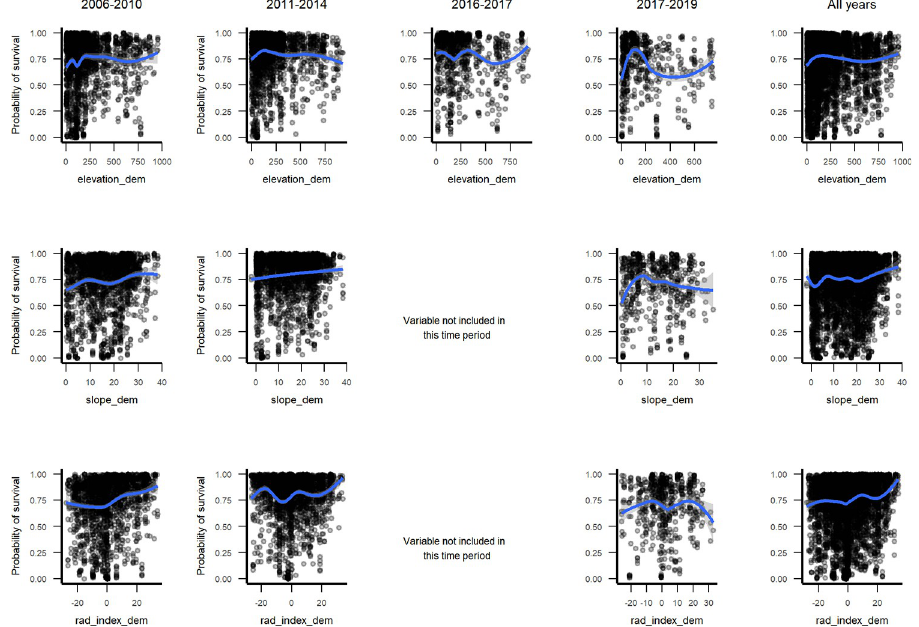
Fig 7. Marginal plots of elevation and slope through time, which had high rank for the interval ending in 2017– 2019 (t4b) but lower rank